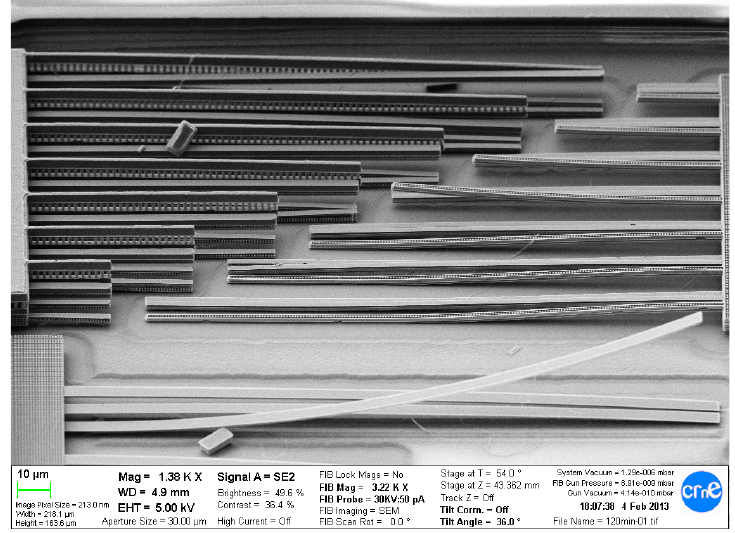
Figure 9. Curled-up M1 beams (left-center) showing the tensile residual stress of this layer. M2 and M3 are curled down due to compressive stress.